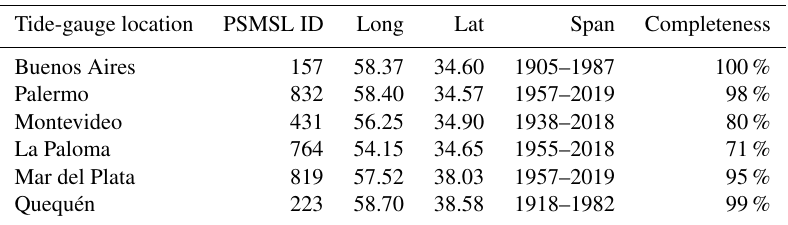
Table 2. PSMSL tide-gauge records (Holgate et al., 2013; Figs. 1, 4). Long and Lat are degrees west longitude and south latitude, respectively. Completeness is the percentage of years during the span that feature